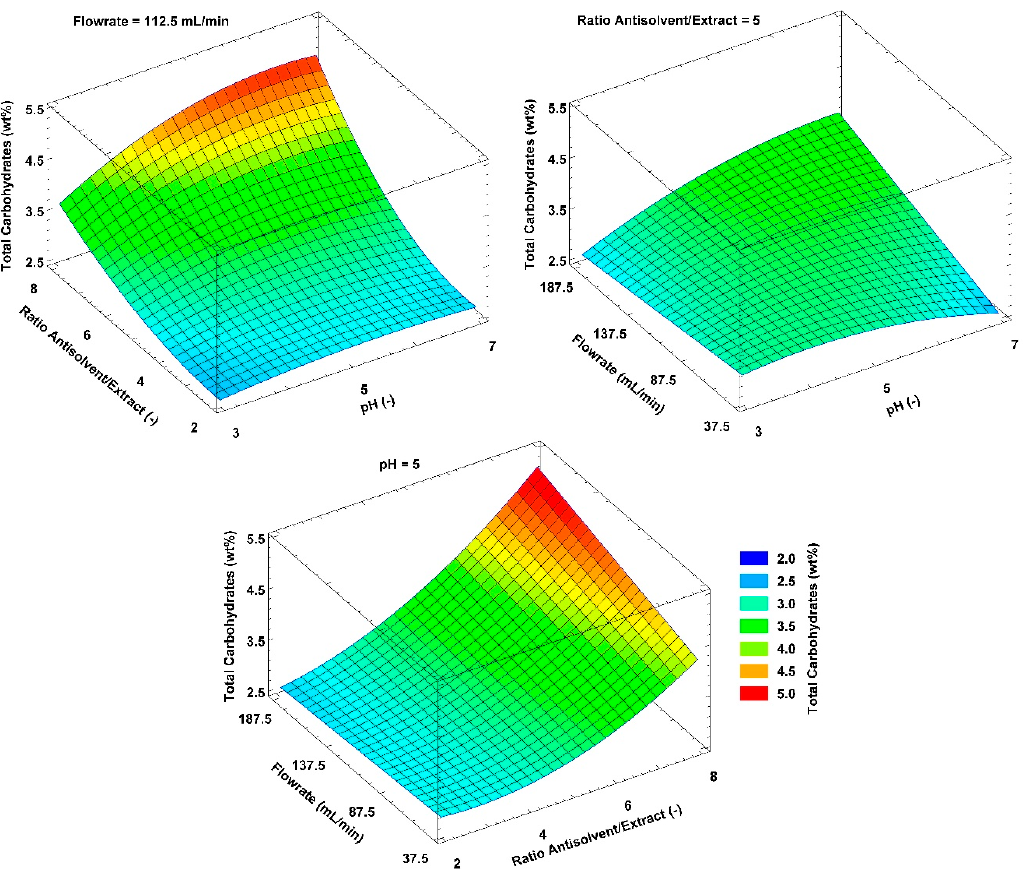
Figure 5. E ff ect of independent variables interaction on total carbohydrate content of the resulting dry precipitate.